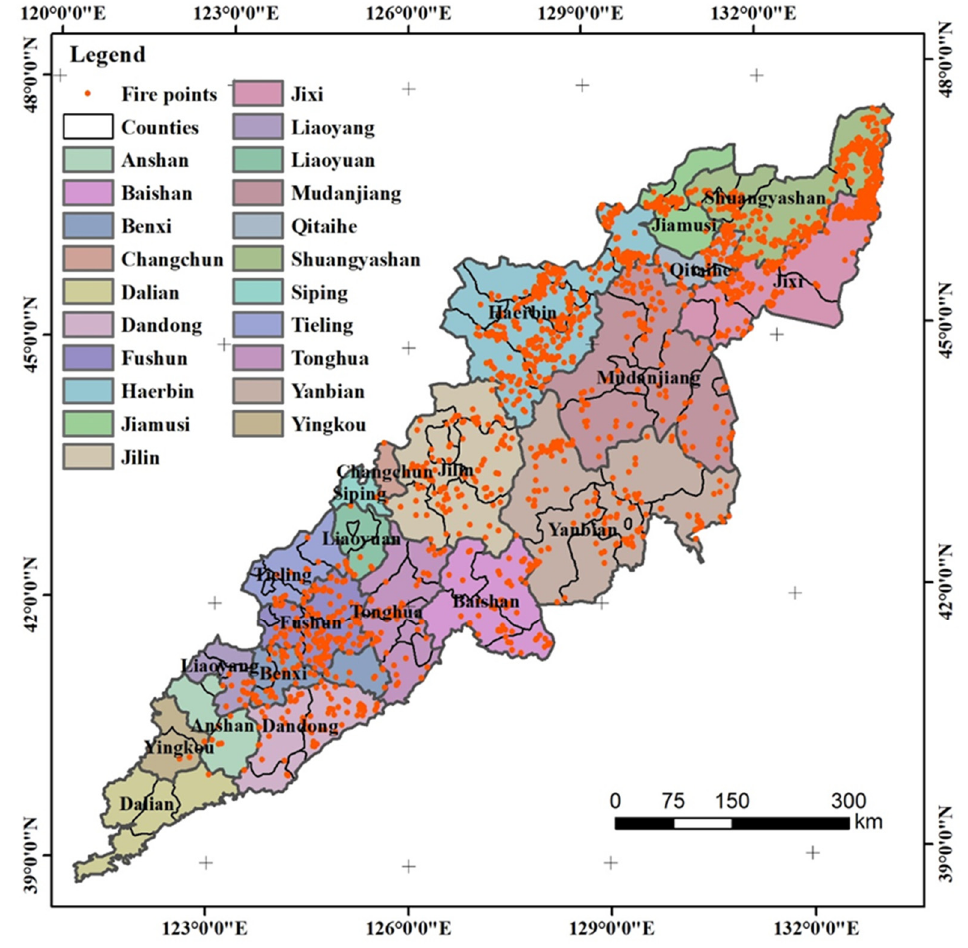
Figure 1. The location of the study area and the distribution of active forest fire points.